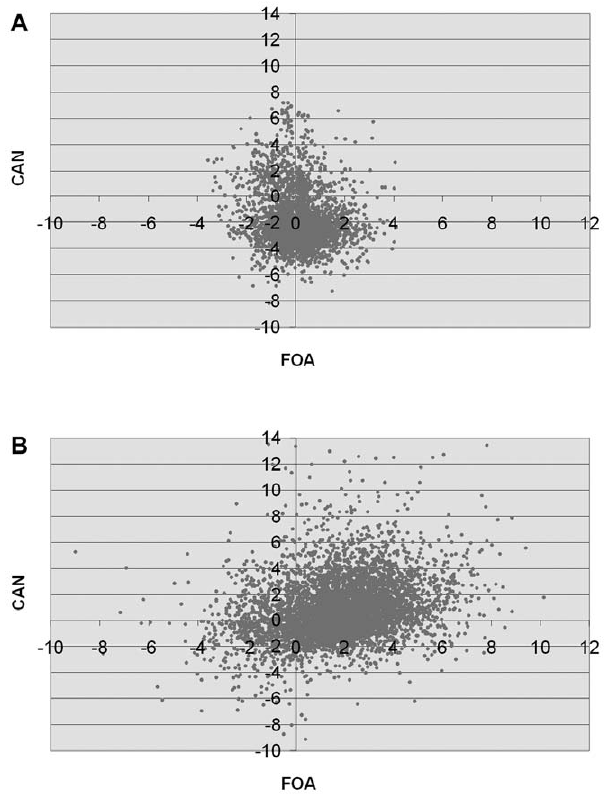
Figure 1. Comparison of genome-wide SLM screen results for CAN1 and URA3 markers. SLM screen results expressed as averaged LogRatio of relative abundance of each deletion clone obtained for CAN1 and URA3 markers were plotted against each other. LogRatio data derived only from the screens for mutator phenotypes show little correlation (A), whereas after subtracting the LogRatio data expressing resistance to the selection conditions and the LogRatio data expressing growth rate for each deletion strain (B) such a correlation exists.